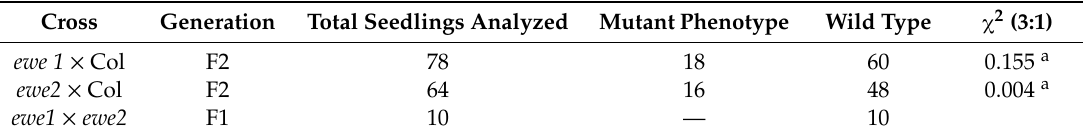
Table 1. Genetic analyses of two mutants obtained in the genetic screen.